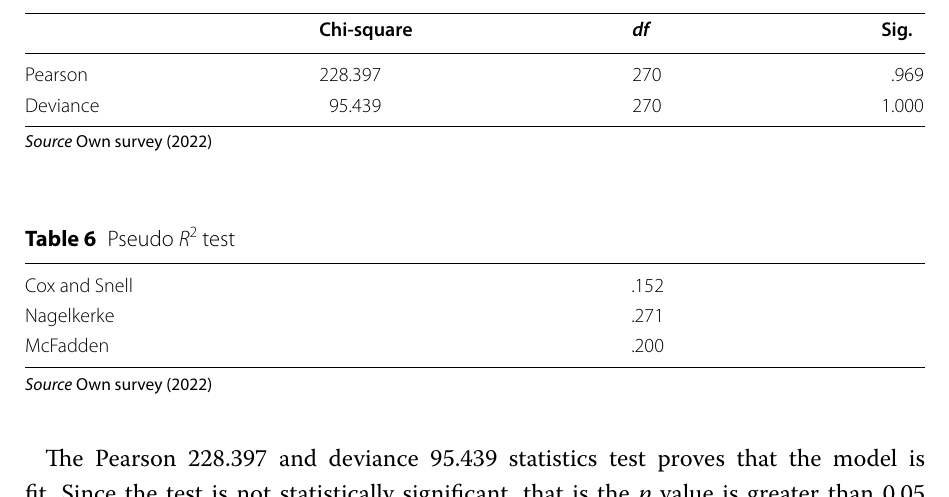
Table 5 Goodness-of-fit